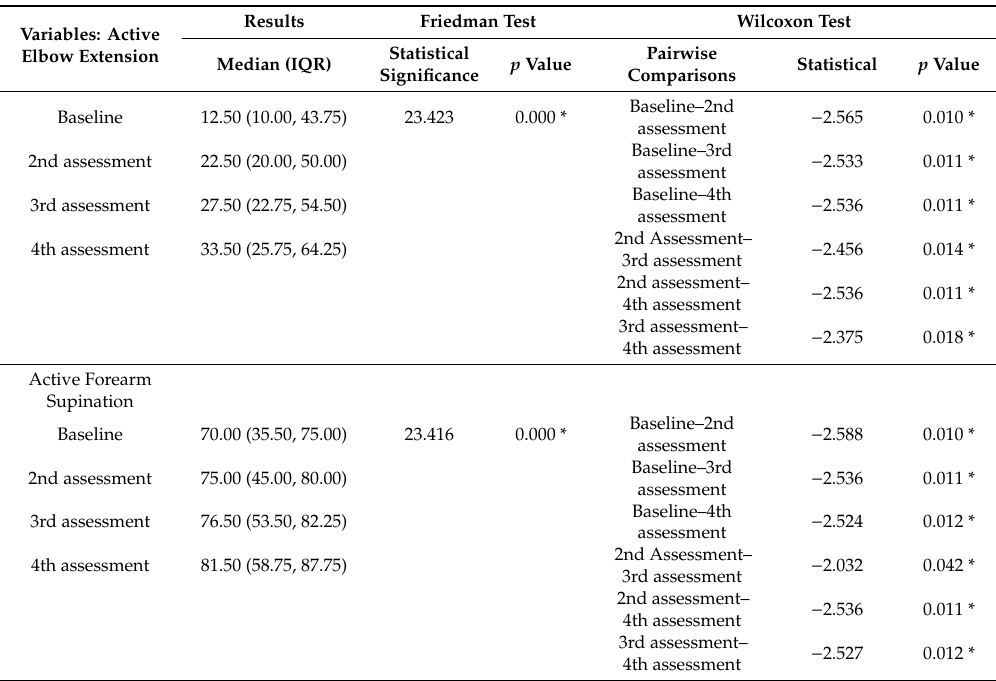
Table 6. Results and pairwise comparisons of elbow extension and forearm